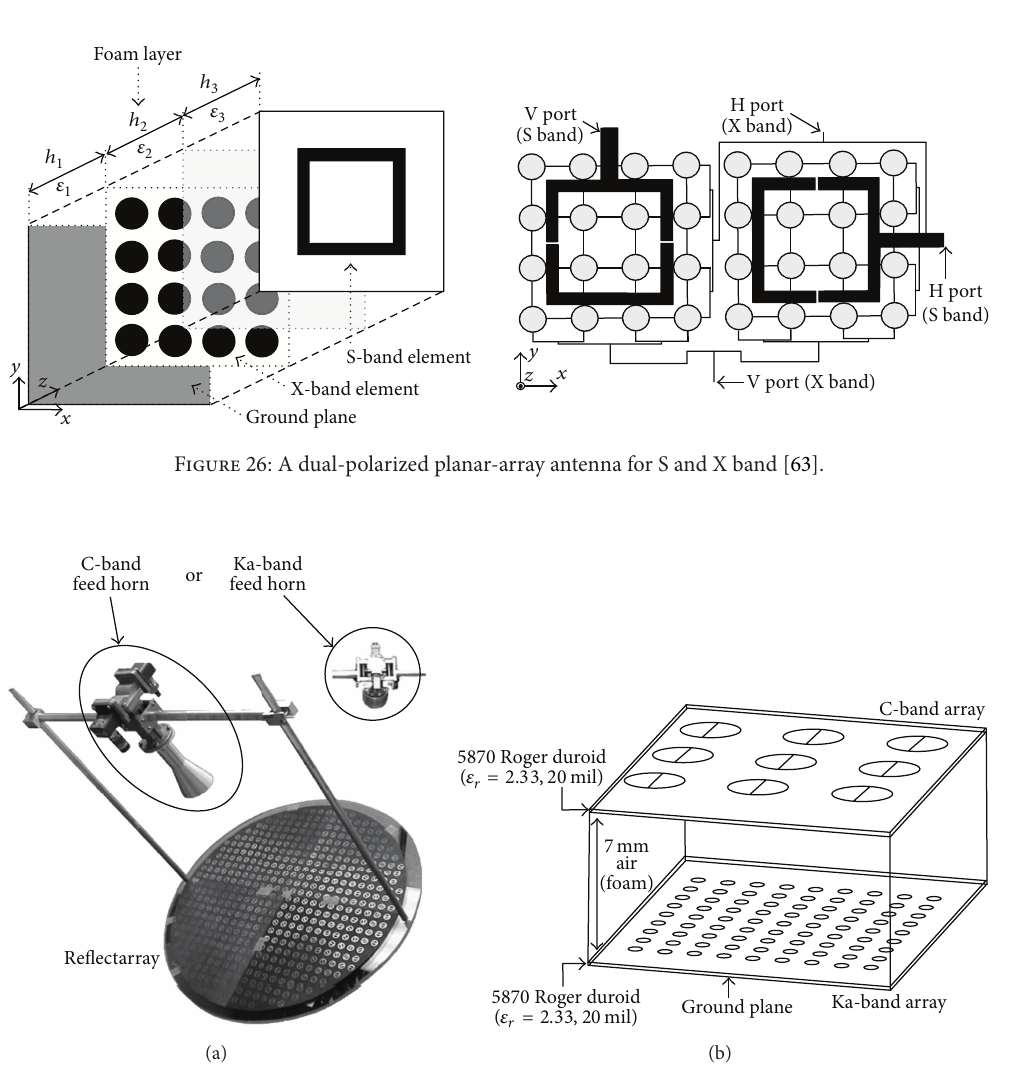
Figure 27: Dual-layer reflectarray topology